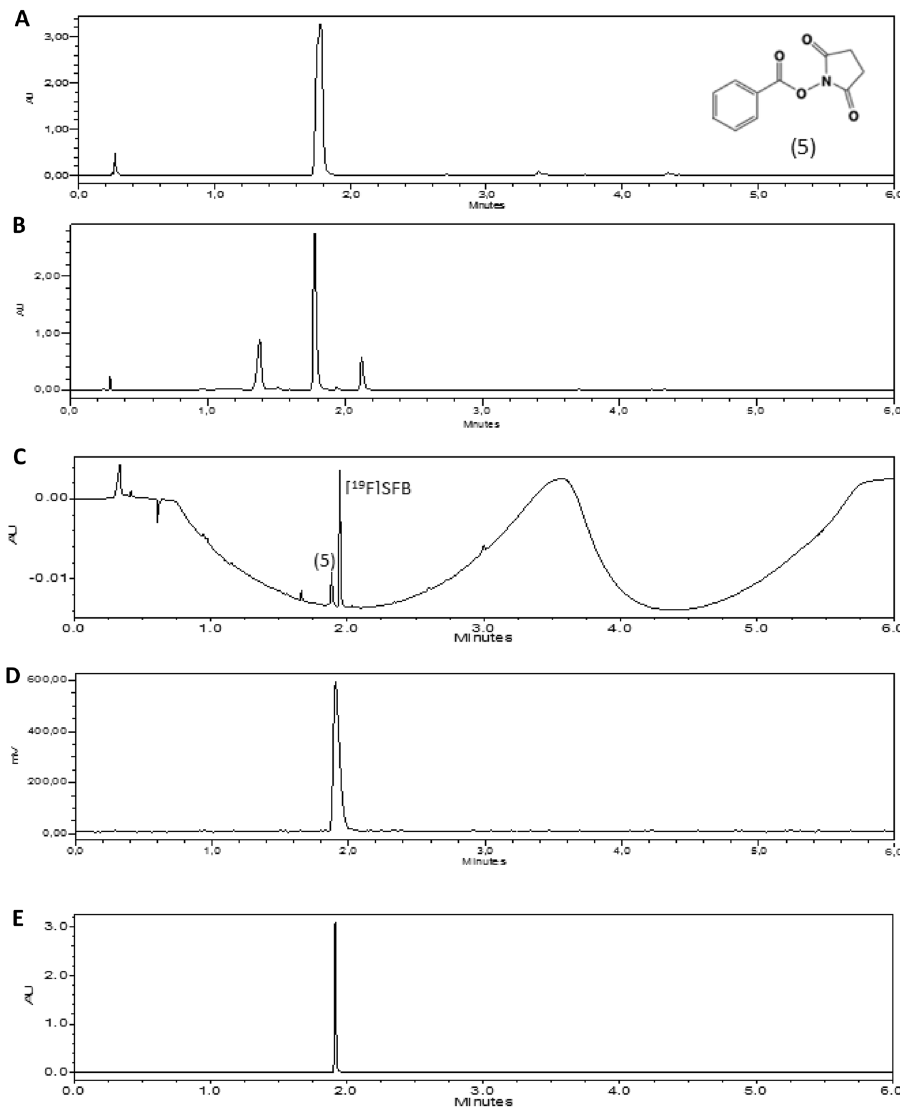
Figure 5. UPLC chromatogram (UV detector, 240 nm) ( A ) N-benzoyloxysuccinimide, ( B ) crude [ 18 F]SFB, ( C ) purified [ 18 F]SFB, ( D ) UPLC chromatogram (γ detector) of purified [ 18 F]SFB and ( E ) [ 19